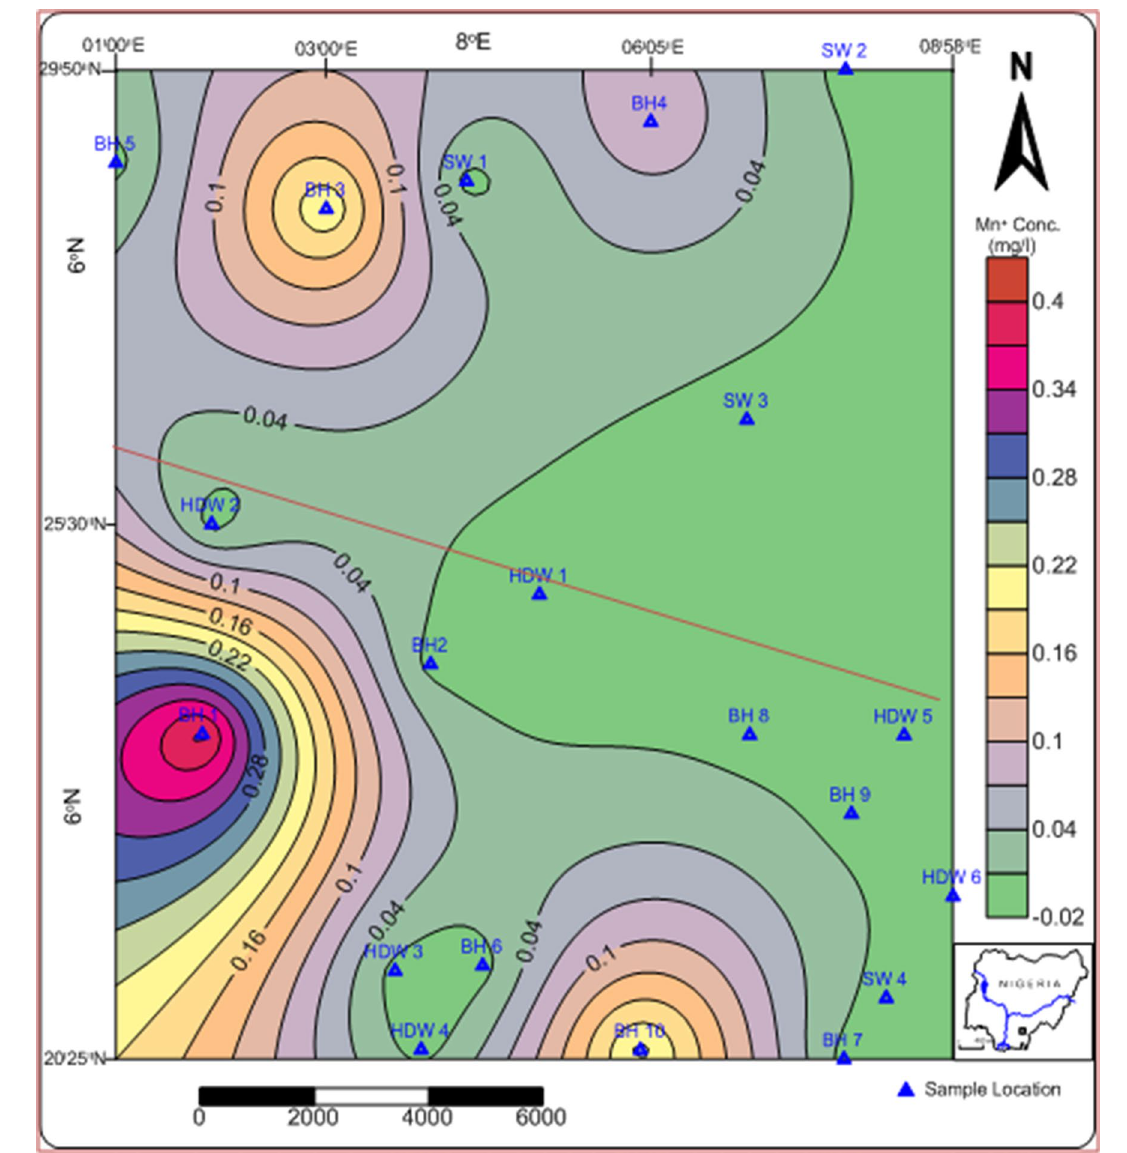
Fig. 17 Map showing dispersion of manganese. Note : Perpendicular line indicates groundwater